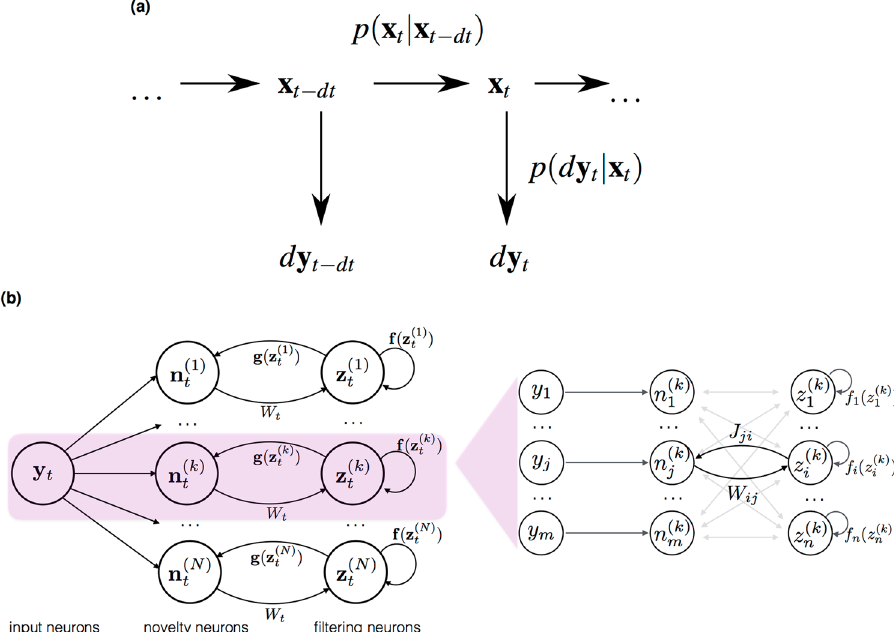
Figure 1. Generative model and neural network implementation. ( a ) Generative model defined by Eqs (1) and (2). ( b ) Implementation of Eq. (4) as a recurrent neuronal network. Left: each particle in the NPF corresponds to one out of N subnetworks, which run in parallel. Here, each circle denotes a neuronal population. Right: connections between neurons within the k th subnetwork in a model with a linear generative function = J g x x ( ) . Novelty neurons n j are connected to filtering neurons z i via the decoding weight W ij . Feedback connections from filtering neurons z i to novelty neurons n j have the weight J ji . We further assume the self-interaction to be local, i.e. the components of the hidden dynamics are independent = f f z z ( ) ( ) single